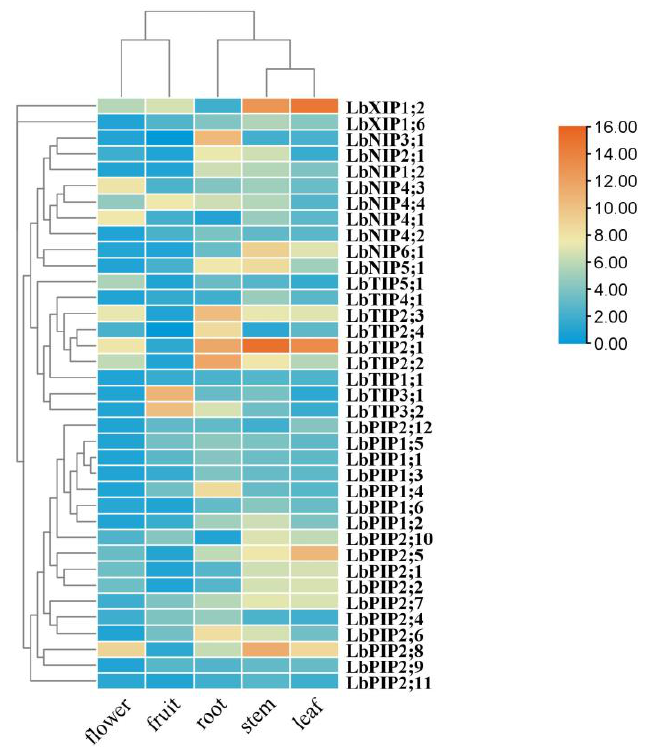
Figure 6. Tissue-specific expression of LbAQP genes. Tissue-specific expression of LbAQPs was determined by quantitative real-time PCR (qRT-PCR) in leaves, young roots, stems, ripening fruits, and flowers with gene-specific primers. qRT-PCR was performed in triplicate, and the fold changes were analyzed via the 2 −ΔΔ CT method using the LbACTIN1 gene as an internal control. Values are the means of three independent experiments.